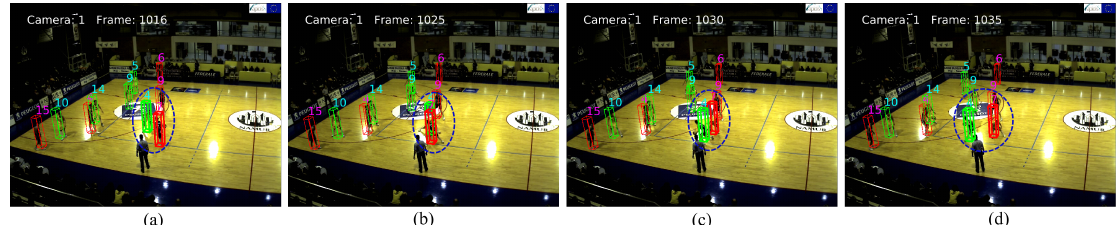
Figure 1. An example of the identity switch problem. It easily occurs when two players annotated with thicker lines are close to each other. ( a , b ) Blue player number 7 (annotated by red bounding box) and yellow player 4 (labeled with green bounding box) are approaching from frame 1016 to 1025. ( c ) The two players separate and then swap their identities in frame 1030. ( d ) The wrong identities remain in frame 1035 and will not change until the next